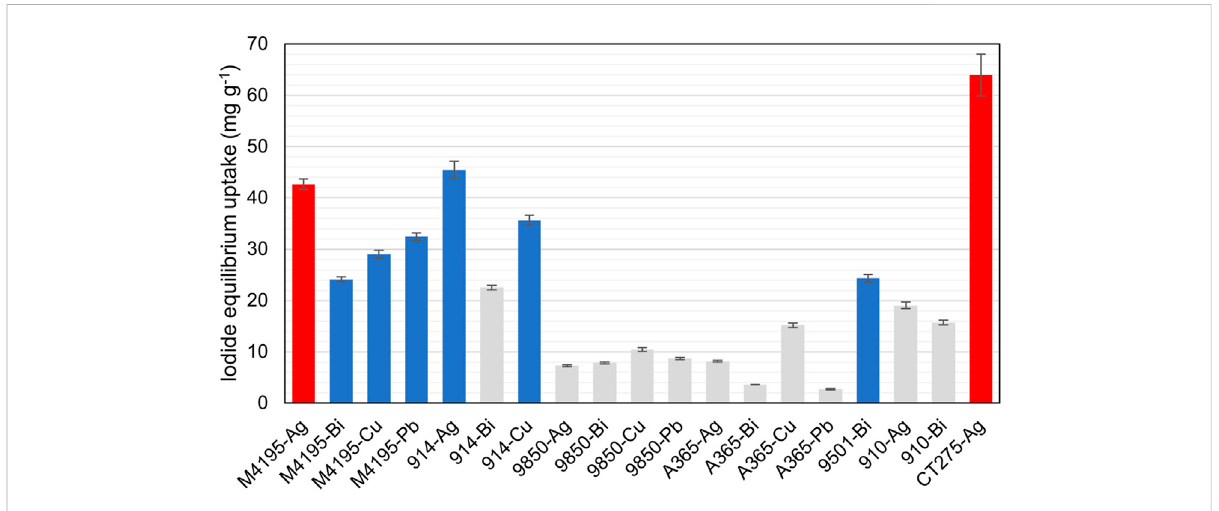
FIGURE 6 Showing the mean iodide uptake capacity of the 19 materials progressed to the fractional factorial experiment. Parameters are as per Figure 4. Red bars = not progressing due to observed precipitation. Grey bars = not progressing due to insuf fi cient iodide uptake. Blue bars =